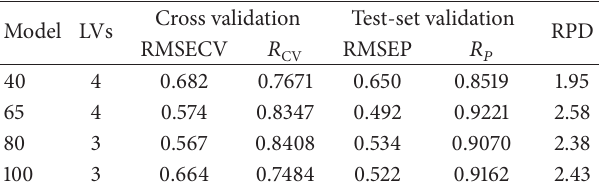
Table 4: Local model performance of different